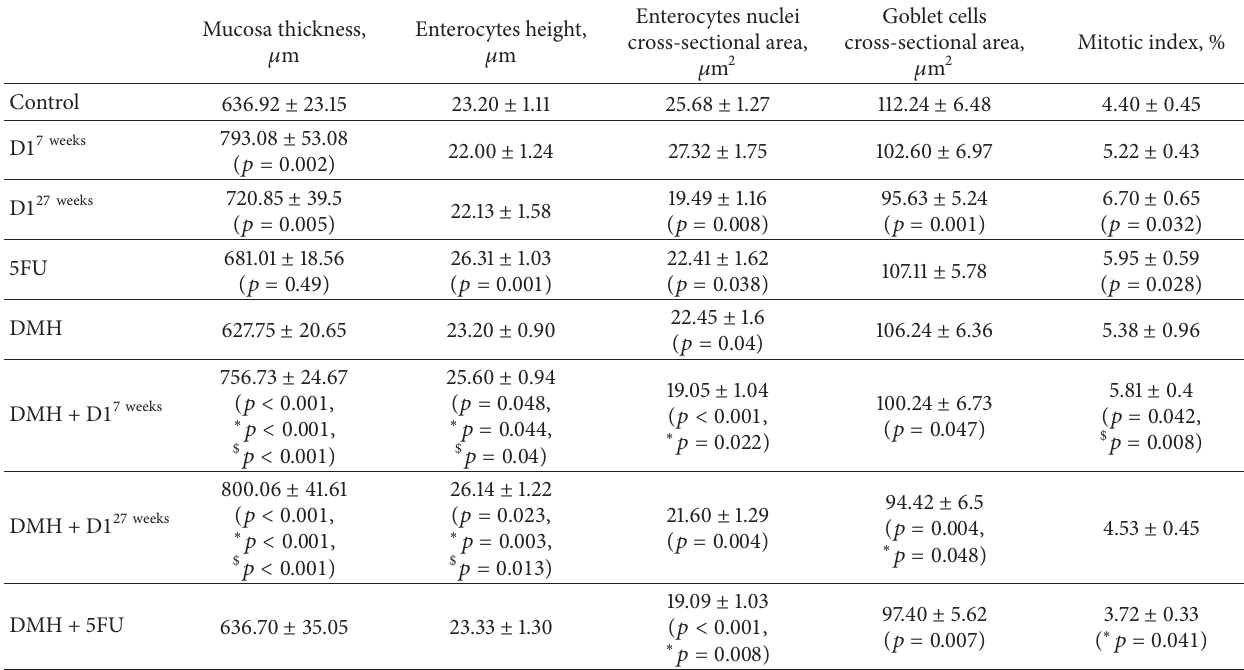
Table 4: Parameters of jejunal mucosa for rats treated by D1 and 5FU under DMH-induced carcinogenesis. Mean ± SEM, 𝑛 = 10 # . Mucosa thickness, 𝜇